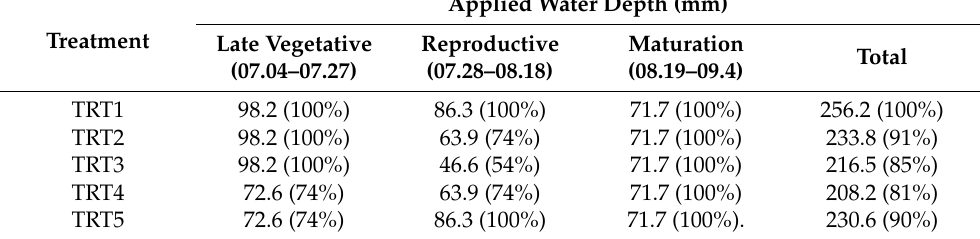
Table 1. Experimental treatments and total applied water depth (percentage of full irrigation treat- ment in parentheses) which includes the amount of irrigation in the late vegetative, reproductive and maturation stages in 2019.